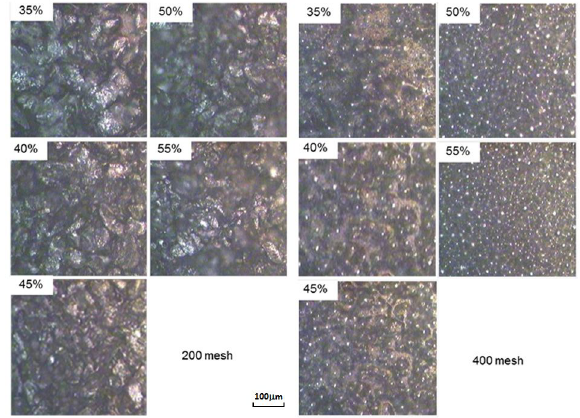
Figure 1: Microscope photos of the coatings with different Mg pow-